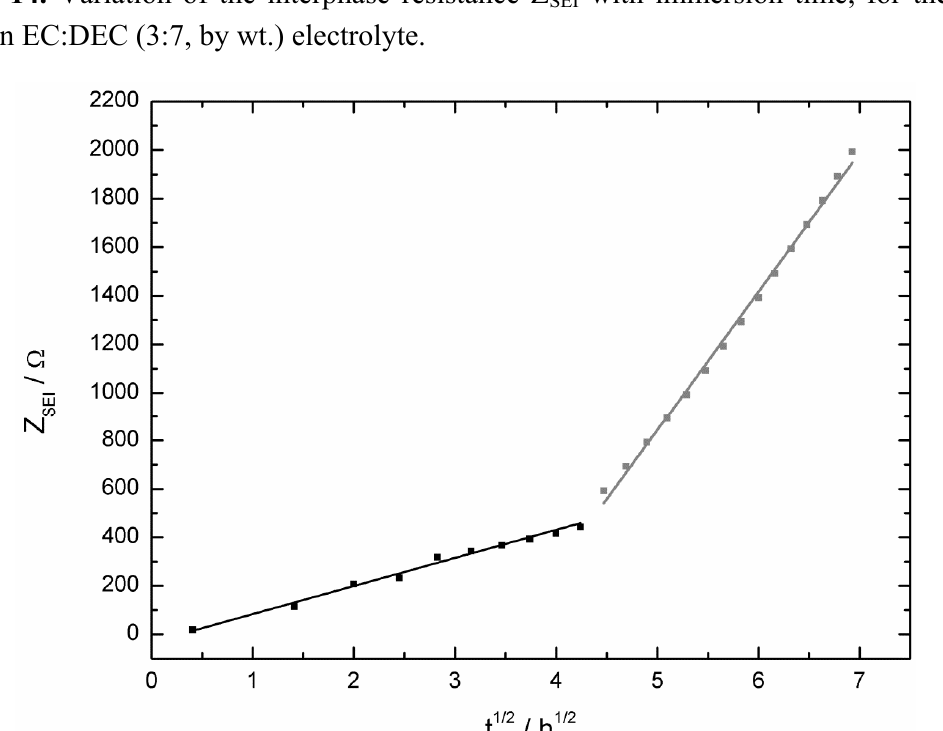
with immersion time, for the 1 M SEI